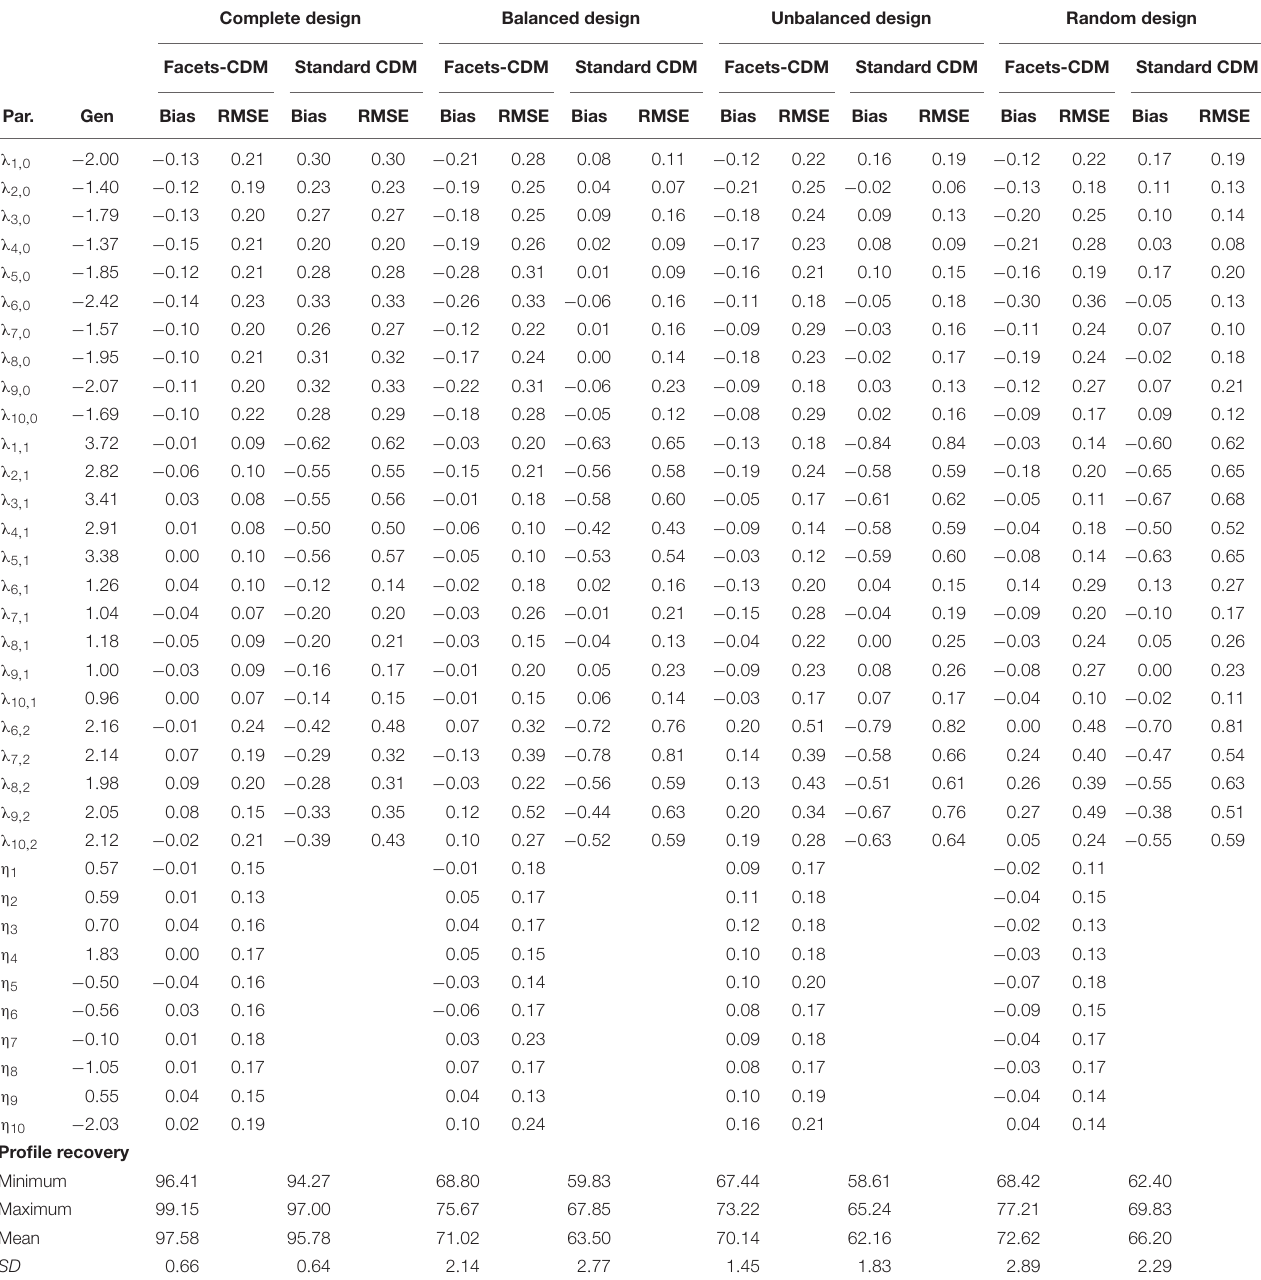
TABLE 3 | Generating values, bias, root mean square error (RMSE), and profile recovery rates (%) in simulation study I